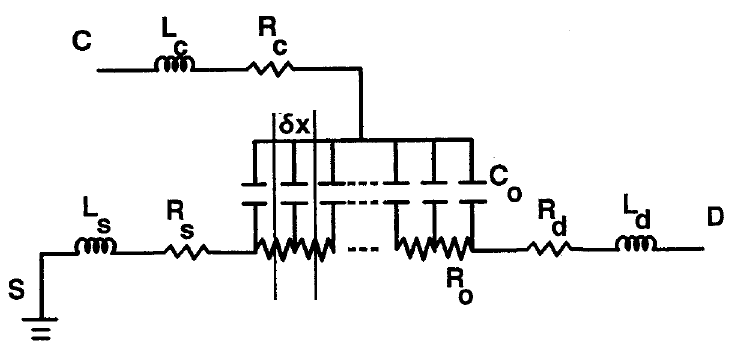
FIGURE 3 Equivalent circuit model under low frequency and open channel condition.